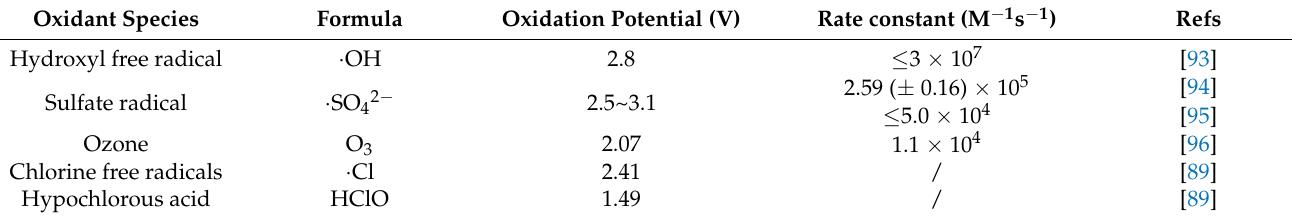
Table 5. The second-order rate constant for the reaction of PFOA with the main